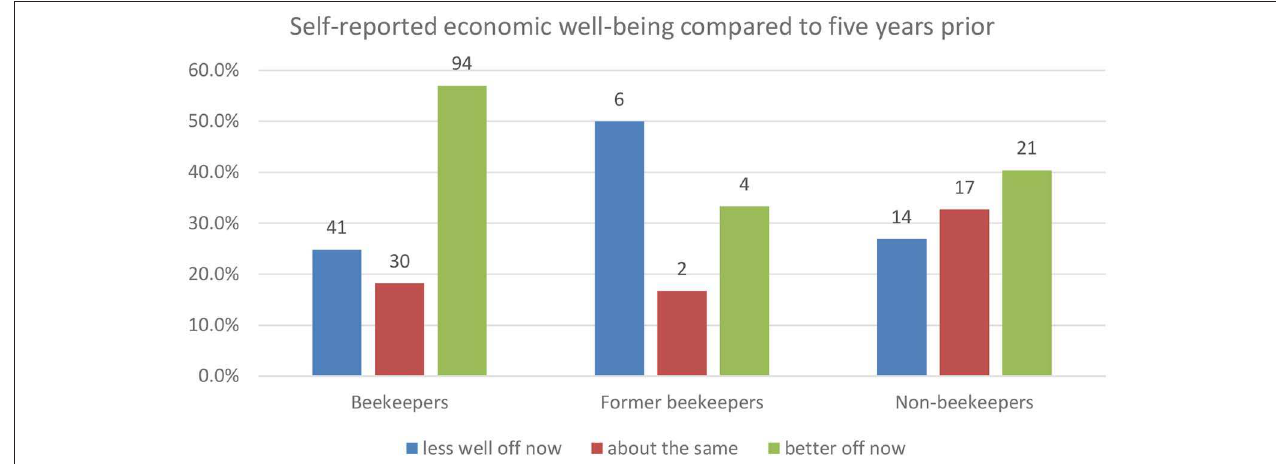
FIGURE 5 | Chart showing average bark hive ownership. Source: All data was collected by asking beekeepers in 2016. No counting was done and all historical number were based on recall. No data was collected for 2012, 2013, or 2014. Two outliers were removed—two beekeepers in Ikelenge reported hive ownership of 1,000 and 1,085 respectively. These were more than twice the next highest at 450 therefore removed from the analysis as exceptional.